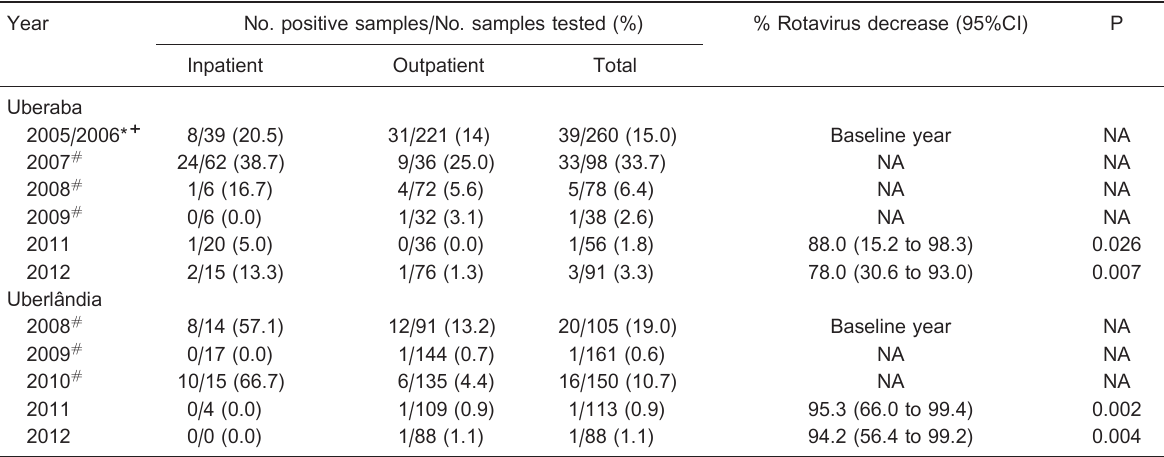
Table 3. Distribution of acute diarrhea and rotavirus-related cases in hospitalized patients and outpatients in Uberaba and Uberlaˆ ndia during 2011 and 2012 compared to baseline years. Year No. positive samples/No. samples tested